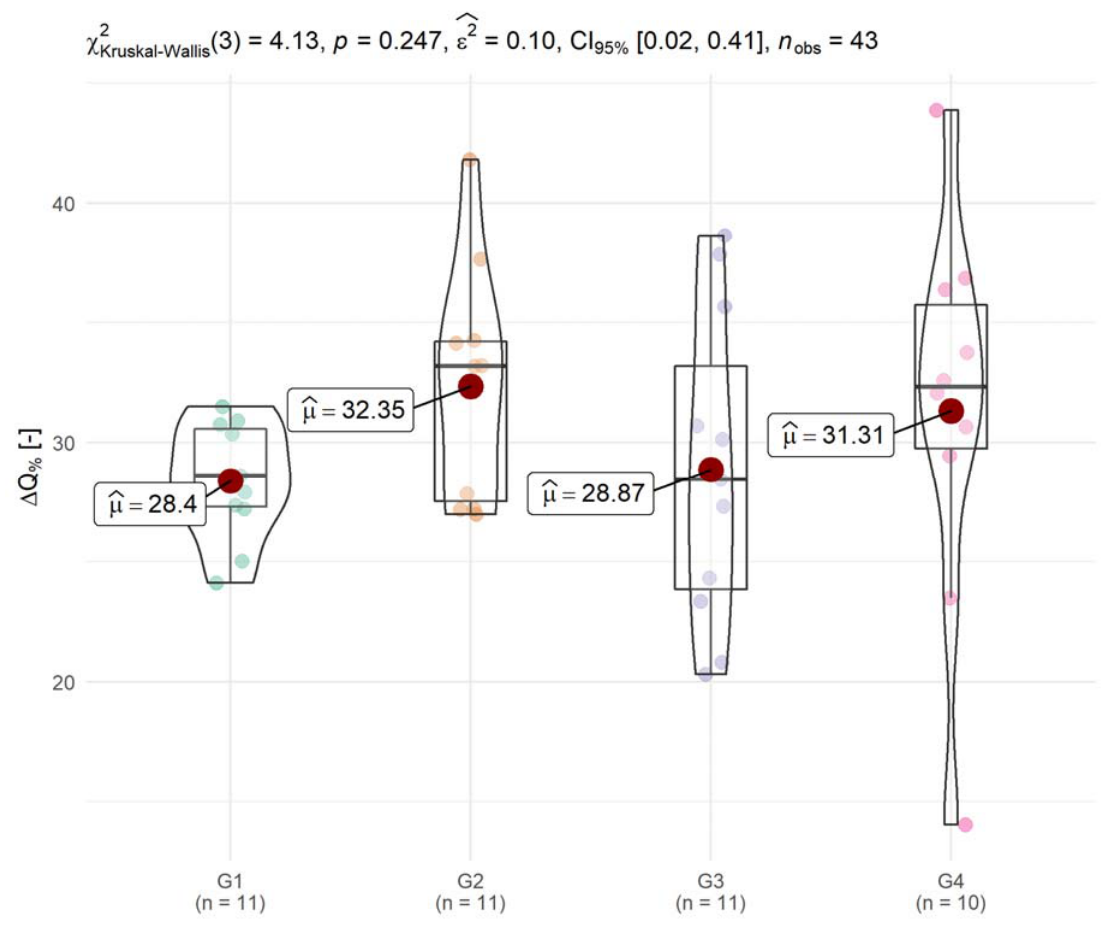
Figure 4. Comparison of decreases in energy consumption between groups of buildings.